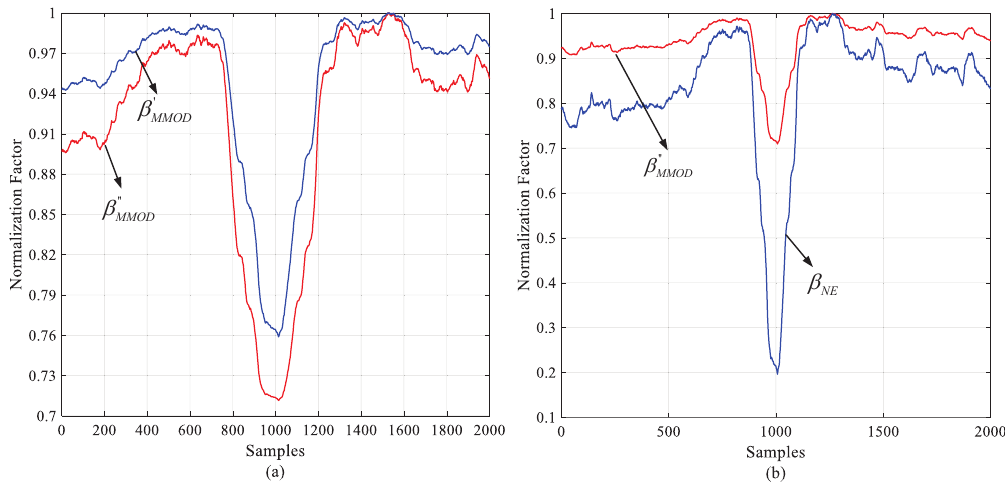
Figure 8. Performance of the proposed normalization factors: ( a ) Comparison of modified MOD vs. frequency offset-compensated MOD normalization factors; ( b ) Comparison of frequency offset-compensated MOD vs. frequency offset-compensated and noise-eliminated MOD normalization factors.